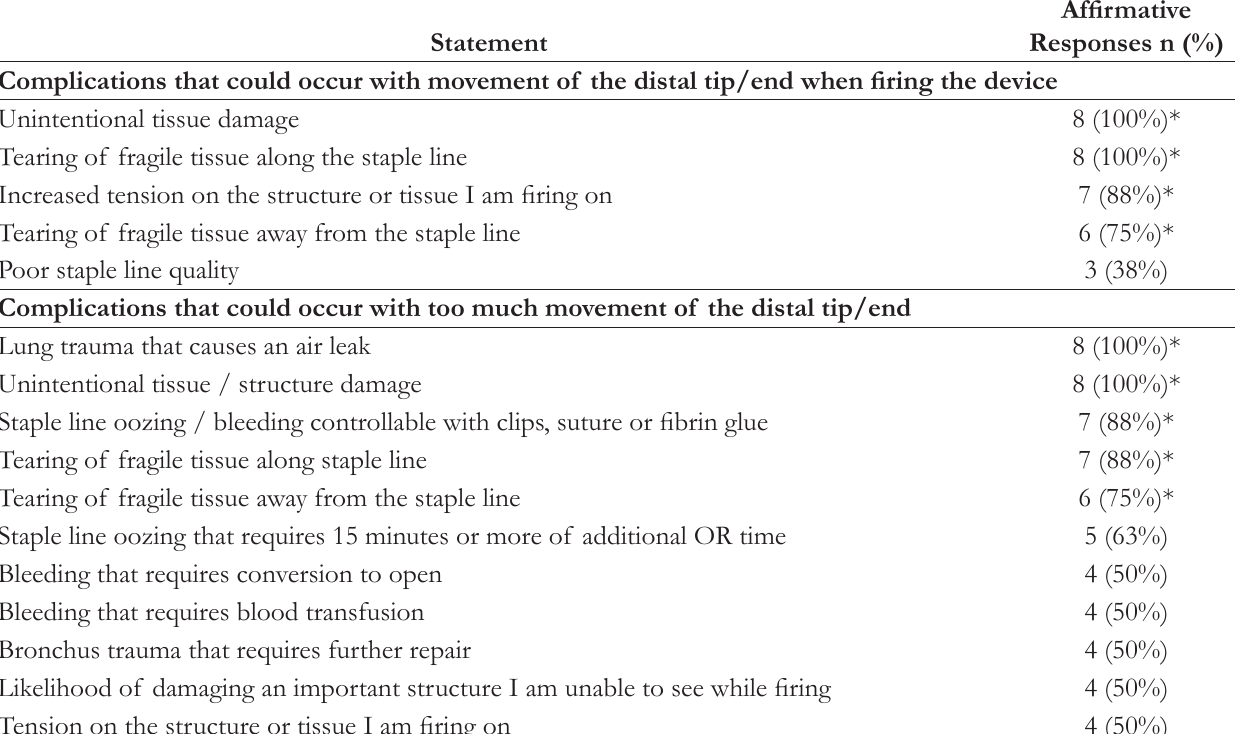
Table 2. Survey 2 Results on the Impact of